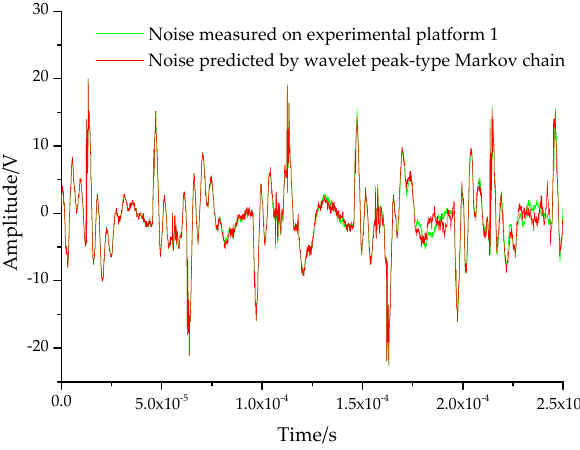
Figure 12. The time-domain waveforms of measured noise before and after modeling.